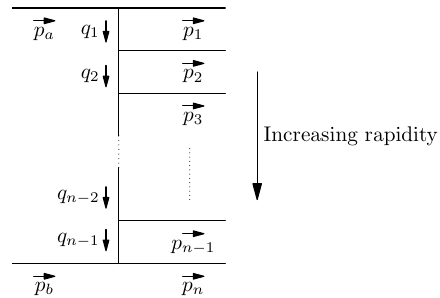
Figure 1. An illustration of the definition of the t -channel momenta in non-overlapping channels or planar